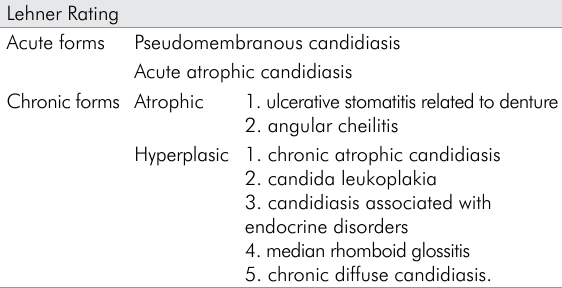
table 2. Lehner Oral Candidiasis